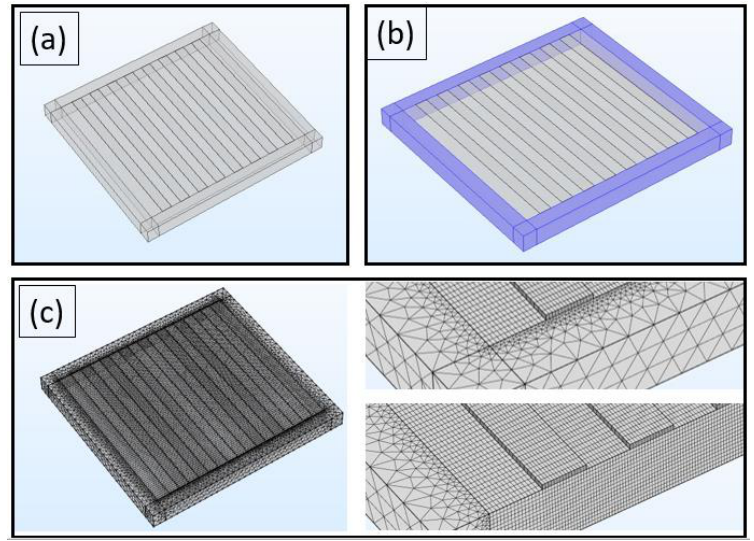
Fig. 1. 3D model (а), place of PML in the model (b), given model grid and enlarged fragment (с).